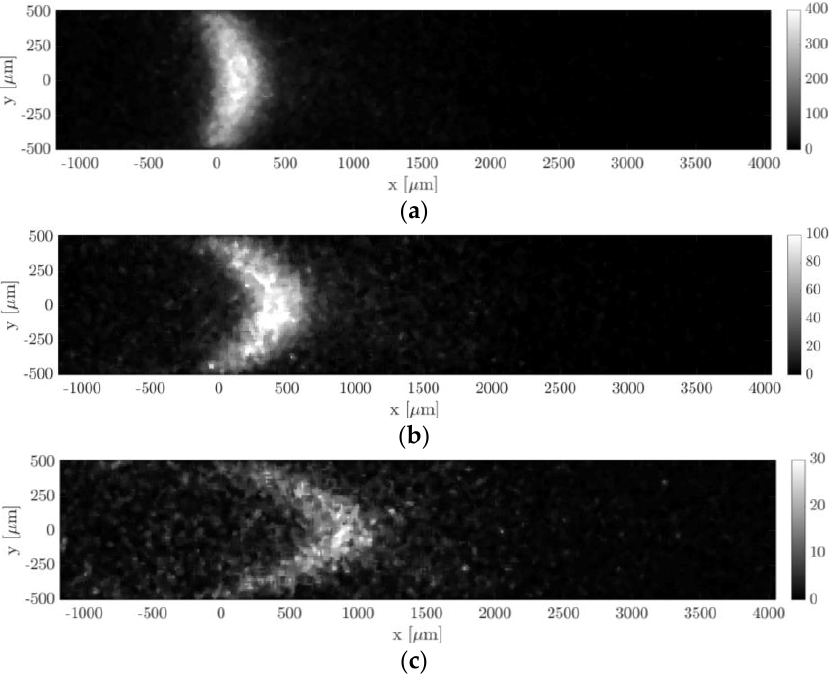
Figure 13. MTV acquisitions of argon–acetone flow with 𝜒 = 20%: ( a ) Δ𝑡 = 10 µs, 𝑝 𝑚 = 27.38 kPa, and Δ𝑝 = 528.4 Pa; ( b ) Δ𝑡 = 25 µs, 𝑝 𝑚 = 28.83 kPa, and Δ𝑝 = 538.8 Pa; and ( c ) Δ𝑡 = 50 µs, 𝑝 𝑚 = 30.36 kPa, and Δ𝑝 = 549.9 Pa. The recording parameters are 𝑁 𝑙 = 100, 𝑁 𝑖 = 20, 𝐺 = 100%, and Δ𝑡 𝑔𝑎𝑡𝑒 = 100 ns. The acquisitions are made with a 4 × 4 binning. The laser pulse energy was varying between 30 and 40 µJ.